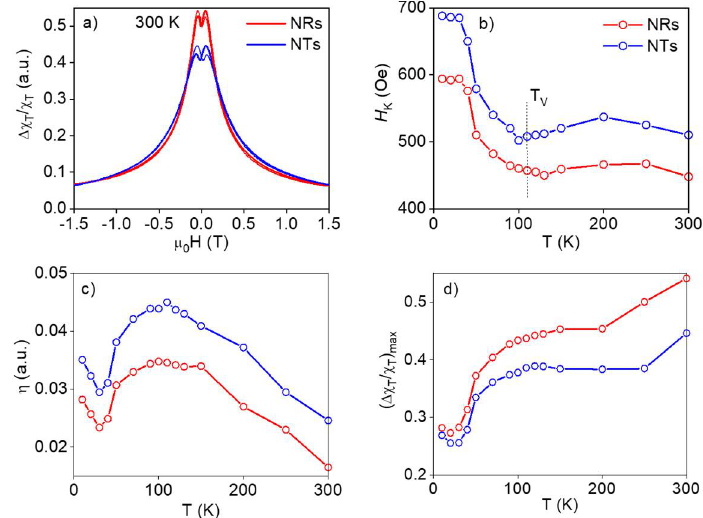
Figure 3. Transverse susceptibility (TS) measurements for the iron oxide NRs and NTs: ( a ) TS bipolar curves measured at 300 K, ( b ) temperature dependence of anisotropy field, H K , (the expected Verwey temperature is indicated by T V ), ( c ) peak height difference ( ɳ ) and ( d ) maximum change in TS (Δχ T /χ T ) max vs. temperature curves as obtained from the peaks in the TS bipolar curves.